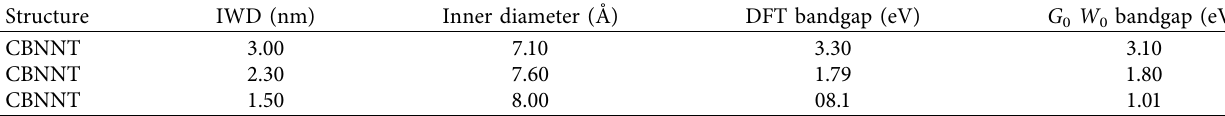
Table 3: Efects of IWD on the electronic properties of